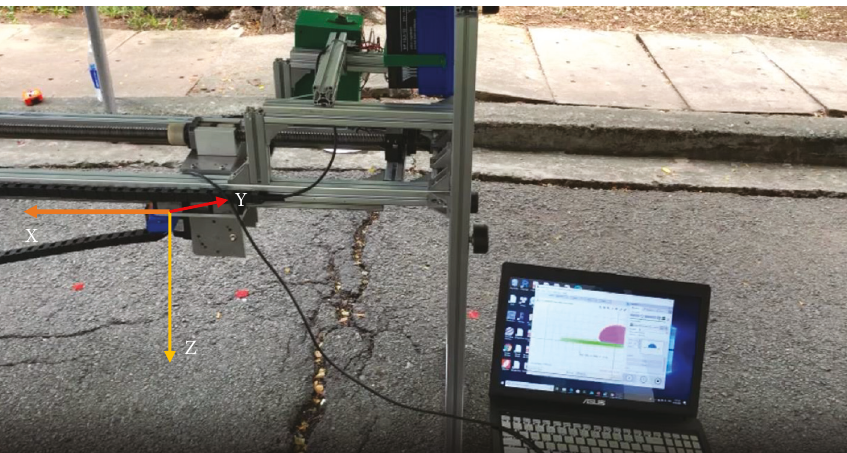
Figure 1: Laser scanning system. The Hokuyo UTM 30 LX is mounted on a frame and can move along the slide rail under the motor power. Table 1: Hokuyo UTM 30LX specification. Model